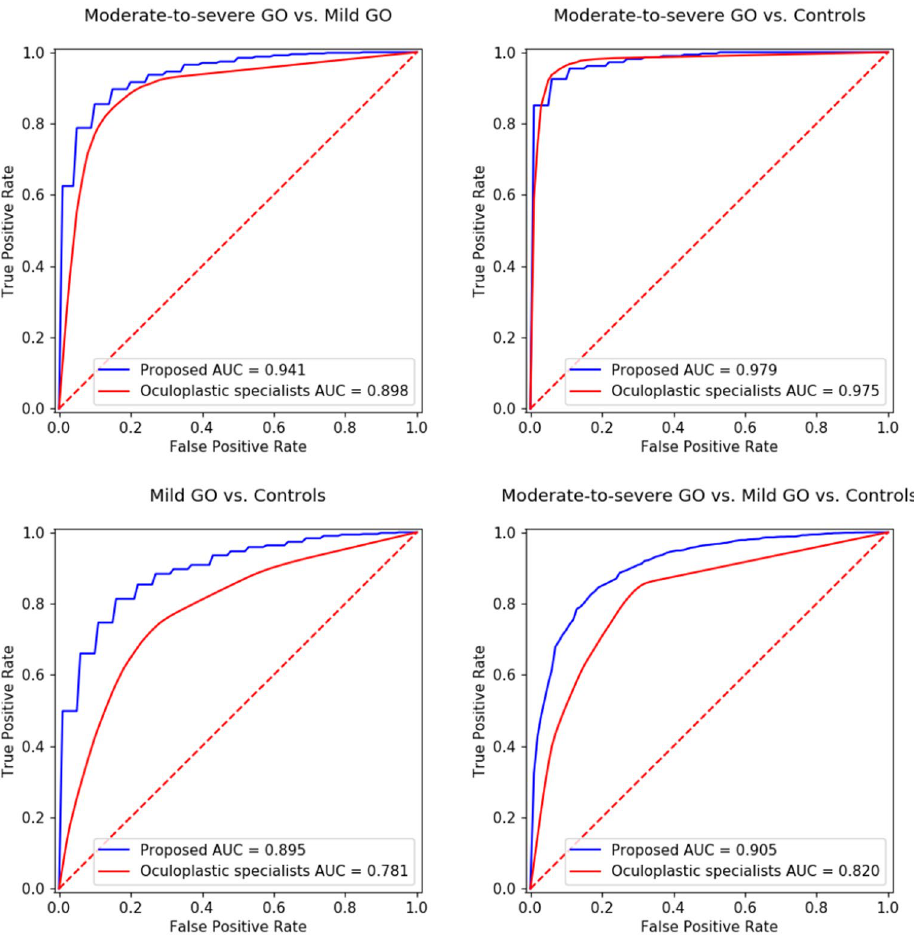
Figure 1. ROC curves of proposed NN and oculoplastic specialists. GO Graves’ orbitopathy, AUC area under the